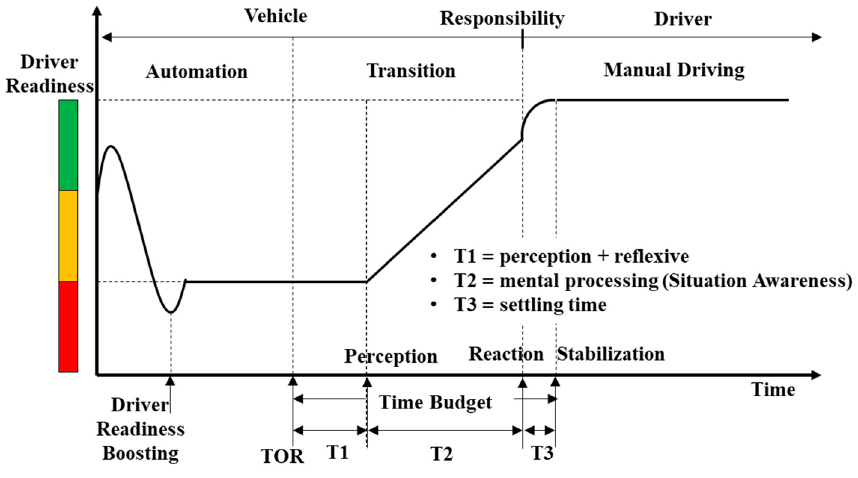
Figure 4. Concept of take-over transition time